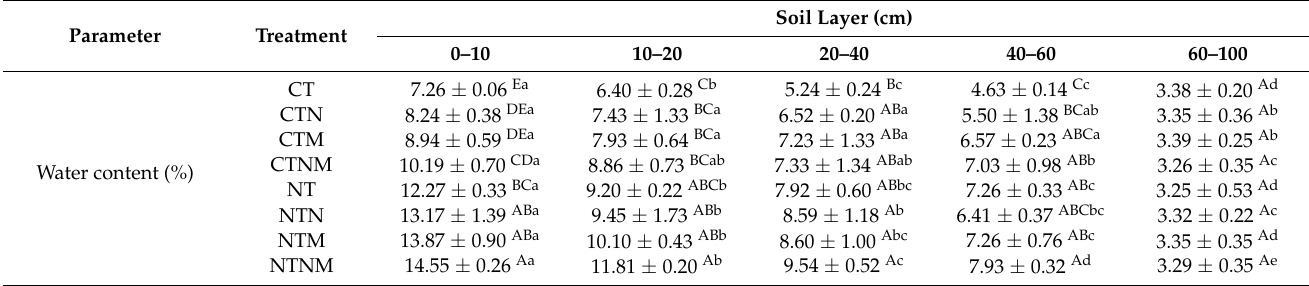
Table 3. Variation in soil water content under different tillage and fertilization